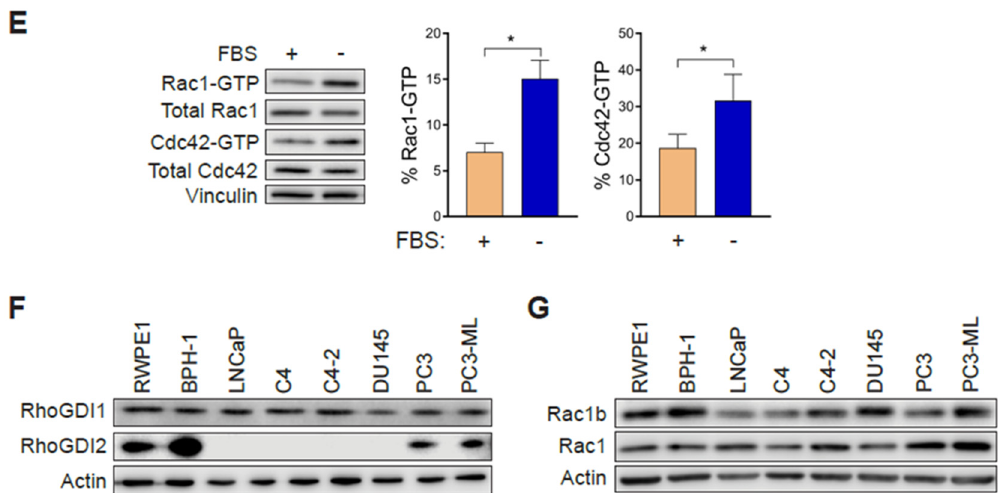
Figure 1. Rac1 and Cdc42 are hyperactivated in aggressive androgen-independent prostate cancer cells. ( A ) Representative Western blots of PAK-binding domain (PBD) pull-down assays showing Rac1-GTP and Cdc42-GTP in cells grown in the presence of 10% FBS. ( B ) Similar experiments were carried out after 24 h serum starvation. ( C , D ) Densitometric analysis of Rac1-GTP / total Rac1 and Cdc42-GTP / total Cdc42. Results normalized to LNCaP cells are expressed as the mean ± S.E. ( n = 4–5). ( E ) Active Rac1 and Cdc42 fractions in PC3 cells growing in the presence or absence of 10% FBS. Results are expressed as the mean ± S.E. ( n = 7) of the percentage of total Rac1 or Cdc42. * p < 0.05. ( F ) Representative Western blots of RhoGDI1 and RhoGDI2 expression in prostate cell lines. ( G ) Representative Western blot of Rac1b expression in prostate cancer cell lines.